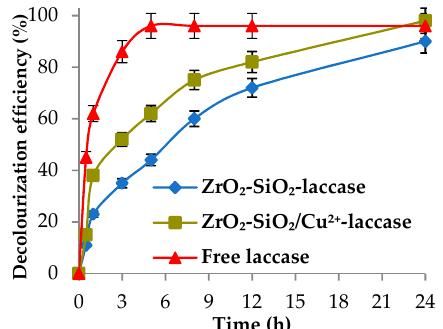
Figure 7. E ff ect of process duration on decolorization e ffi ciency of the RBBR dye using free laccase and Figure 7. Effect of process duration on decolorization efficiency of the RBBR dye using free laccase synthesized biocatalytic and synthesized biocatalytic systems.